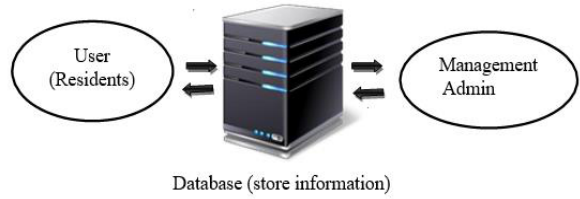
Figure 5. Database acts as data storage for complaints and record management.